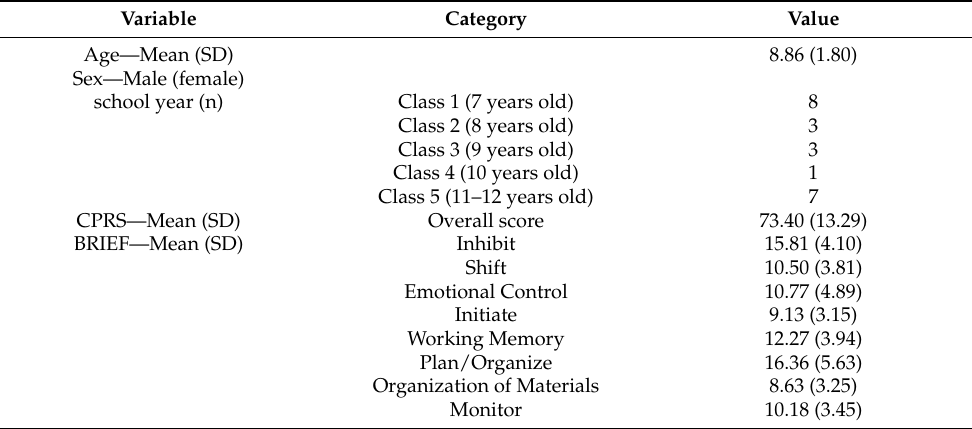
Table 1. Demographic